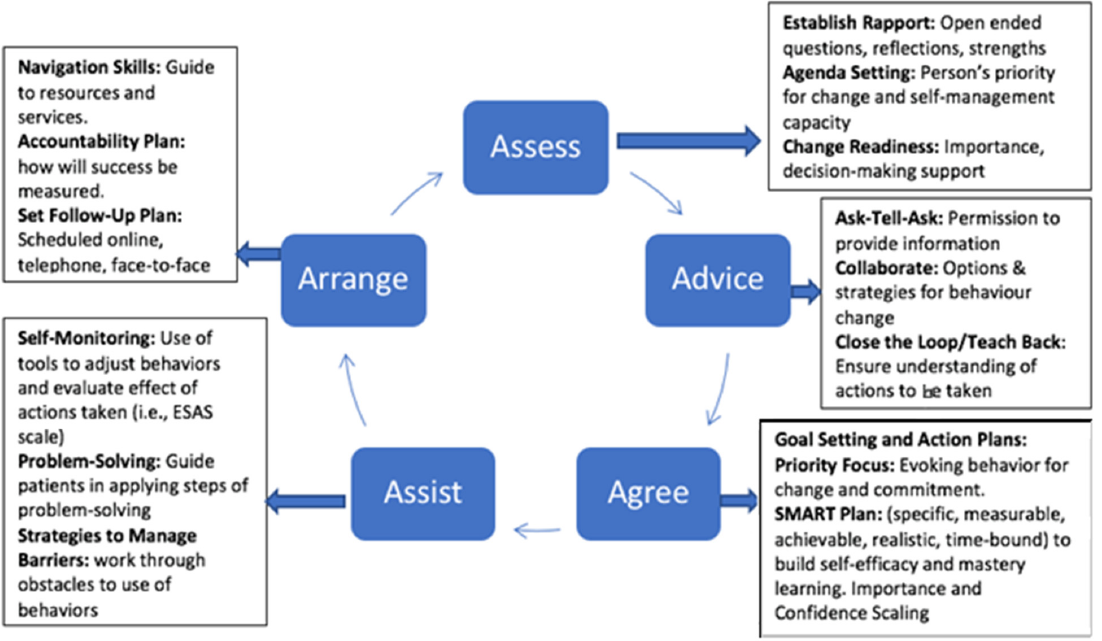
Figure 2. Self-management support microskills integrated in 5As behavior counseling process; ESAS = Edmonton Symptom Assessment System. Used as routine symptom screen in centers.